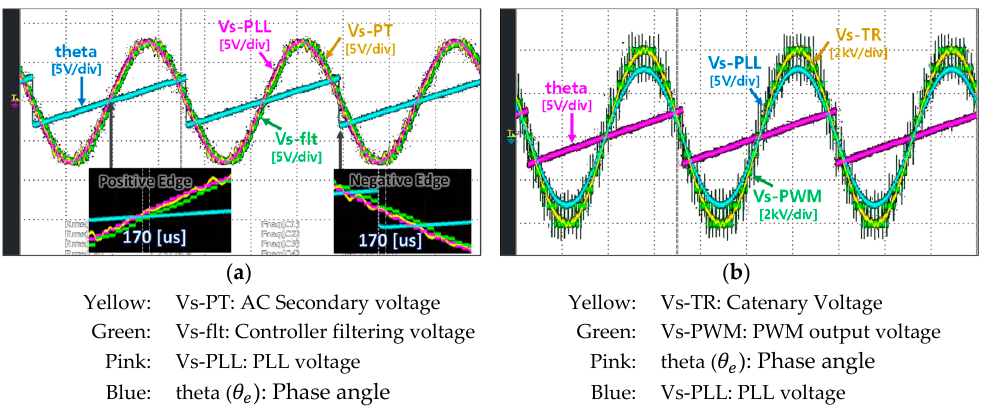
Figure 19. Actual system voltage PLL characteristics: ( a ) Phase detection and ( b ) PWM synchronous.